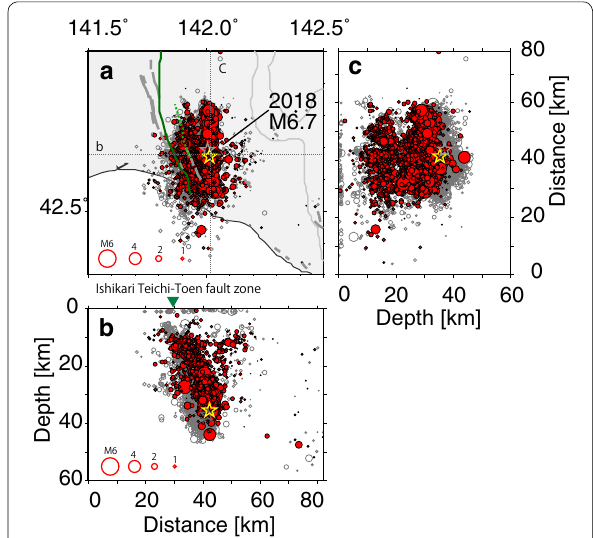
Fig. 3 Distribution of initial (gray circles) and relocated hypocenters (red circles) in the present study in the period of September 6 to October 1 (3782 events). a Map view, b E–W strike, and c N–S strike vertical cross-sections. The initial and relocated mainshock hypocenters are indicated by gray and yellow stars, respectively. In a , the green line and the thick gray lines, respectively, denote the Ishikari Lowland eastern edge fault system (Ishikari-teichi-toen fault zone) and active faults. In a , the thin green dashed line denotes the Atsuma fault by Matsuno and Ishida (1960). The thin gray lines denote the Kamui-Kotan metamorphic belt. In b , the green triangle indicates the location of the Ishikari-teichi-toen fault